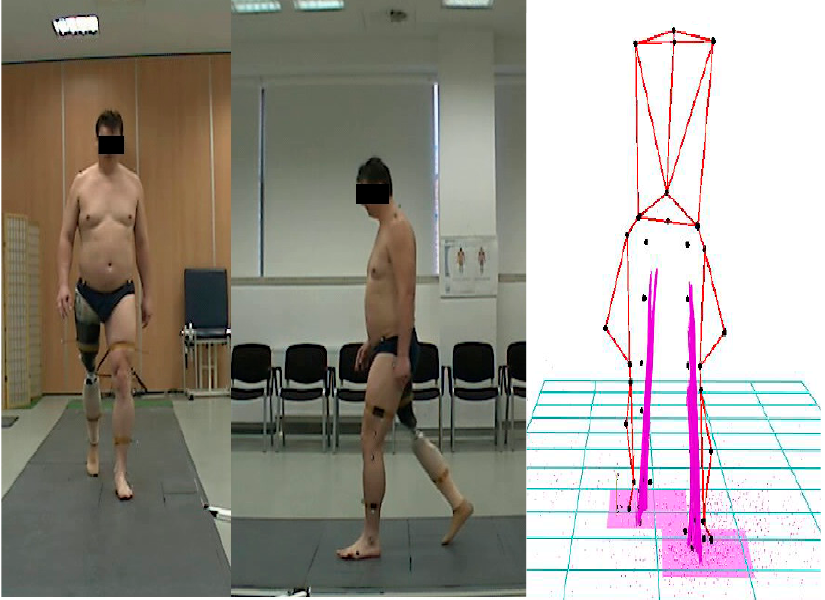
Figure 1. Measurement of gait kinematics and kinetics. Front and side view and model projection created from marker tracking by BTS System.